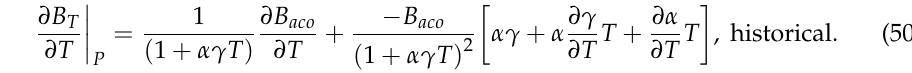
V ( P ). Strässle et al. [51] were puzzled by their EOS determination for B T at 298 K, with the EOS being as predicted by historic Equation (23), but not their 80 K value, and so reevaluated their data with an untested cryogenic calibration, attributed to in a personal communication, which yielded the desired historic result. As shown in Figure 8a, the EOS analysis of lead volumes at low P underestimates the bulk modulus, so their fitting approach only appears to agree with this historic adjustment. Rather, fitting lead vol- umes over the stability range of its bcc phase to a high-order polynomial agreement with B aco , and do not require amending via Equation (23). As demonstrated for the alkali hal- ides, bulk moduli trends with T for lead from volumetric and acoustic techniques are parallel, and so the historic correction is refuted. Soft alkali metals have also been studied by both XRD and acoustic techniques (Figure 10). The trends are nearly parallel. At 298 K, length-change measurements better agree with B aco than with the cryogenic volumetric studies, except for Na. The historic correction at 298 K exceeds or matches the difference between the various measurements, and thus agreement of absolute values involves random experimental uncertainties as is evident from compiled data (Figures 5–7).